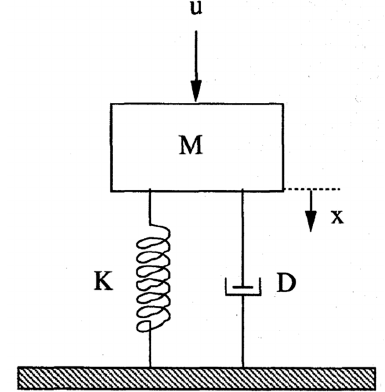
Figure 13. The nonlinear mass–spring–damper model.